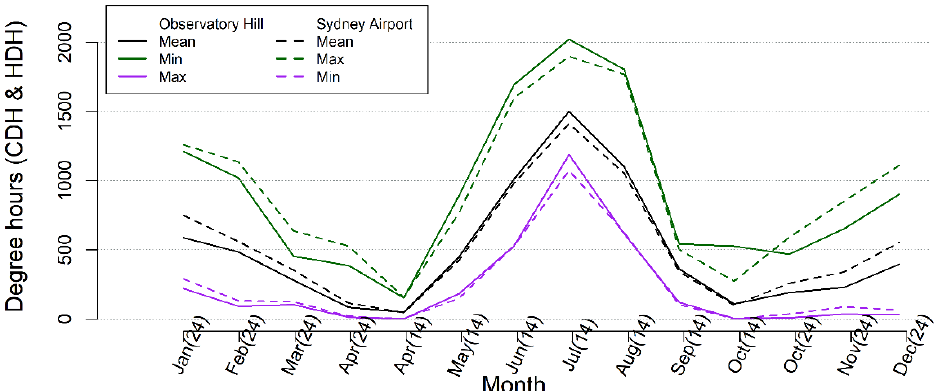
Figure 5. Combined monthly mean, maximum and minimum values of T14 and T24 at both stations.